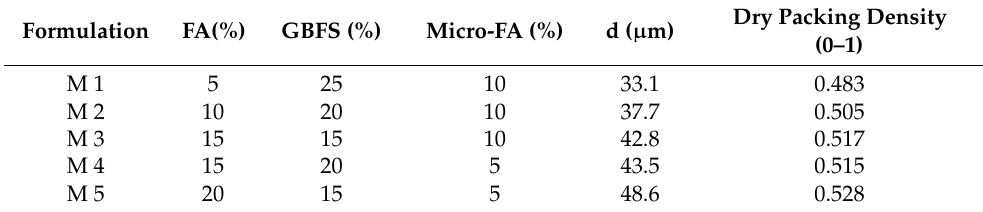
Table 2. Geopolymer concrete samples investigated by Kashani et al.: precursors proportions, particle size, and dry packing density (adapted from